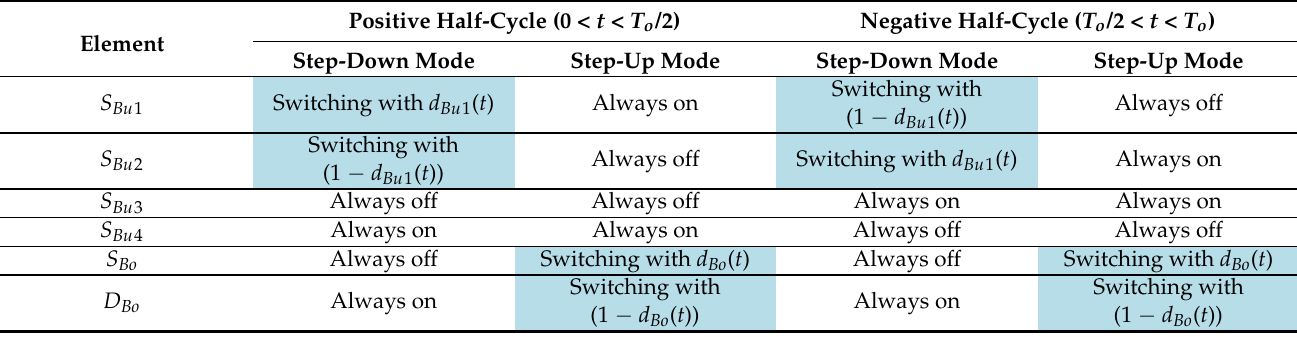
Table 1. Status of switching elements of the proposed high-gain inverter.